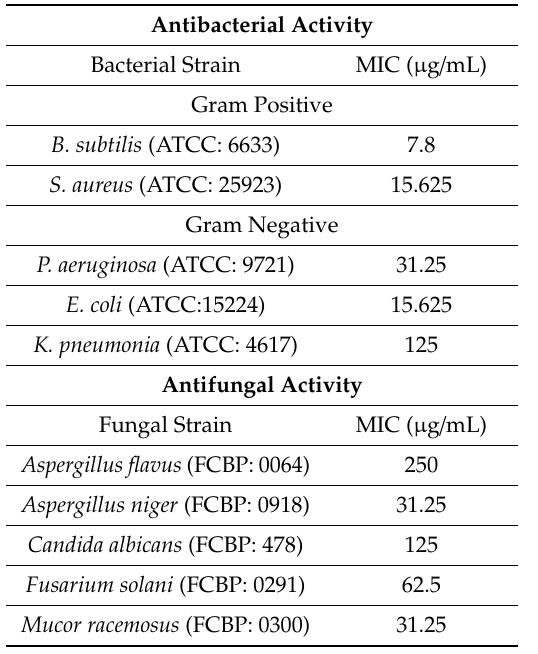
Table 2. MICs values of di ff erent bacterial and fungal